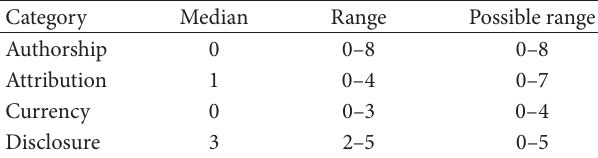
Table 5: Description of transparency categories